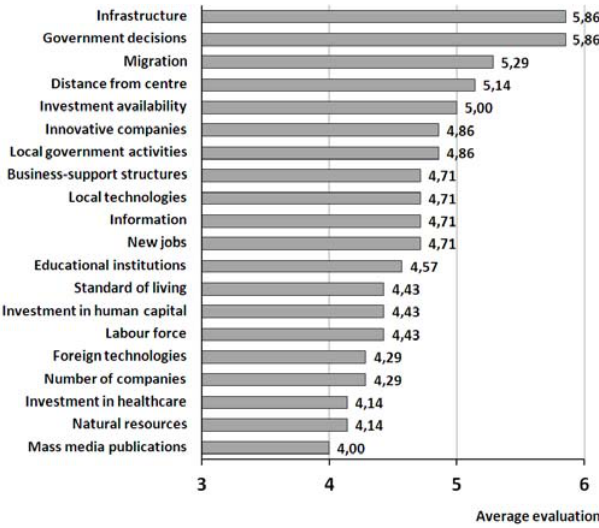
Fig. 5. Expert evaluations of the main factors influencing Latvian regional